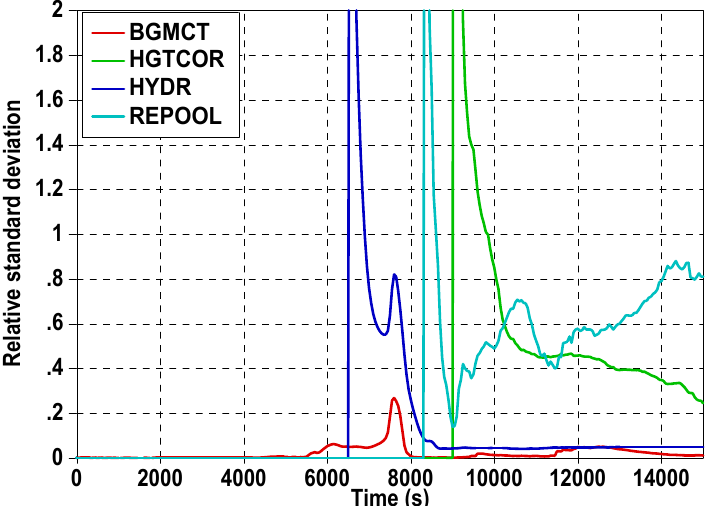
Figure 11. Relative standard deviations for variables related to core damage description.